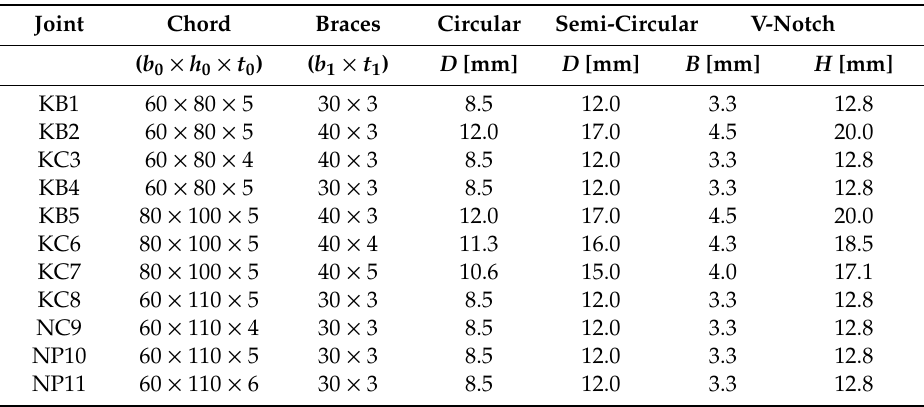
Table 4. Vent hole dimensions in the extended